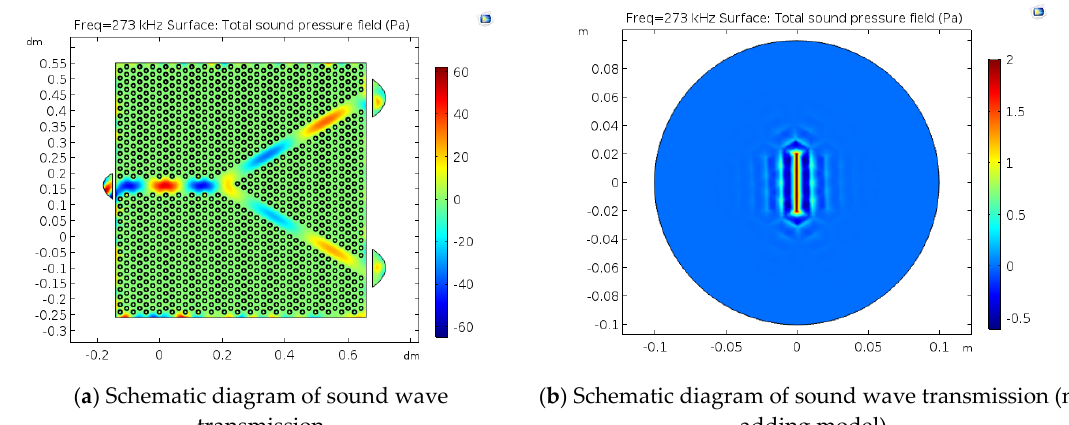
Figure 2. Schematic diagram of sound wave transmission: ( a ) Schematic diagram of sound wave transmission; ( b ) schematic diagram of sound wave transmission (no adding model).